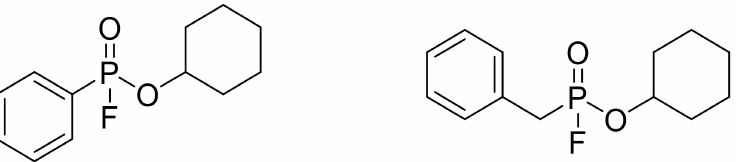
Figure 4. Chemical formulas of cyclohexyl phosphonofluoridates that act as inhibitors for chymotrypsin-like